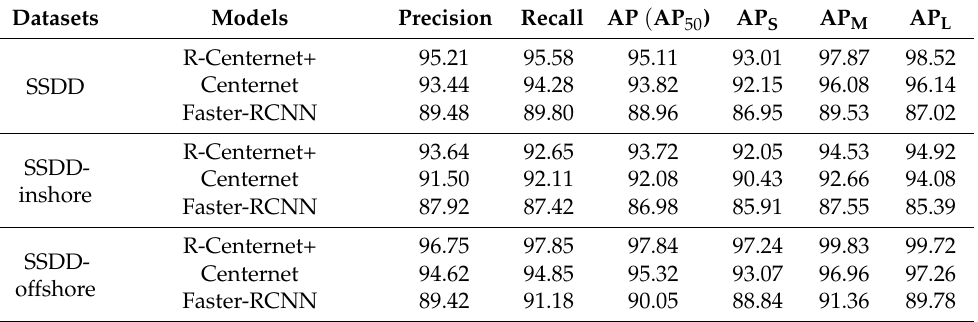
Table 8. Experimental results on the SSDD dataset.